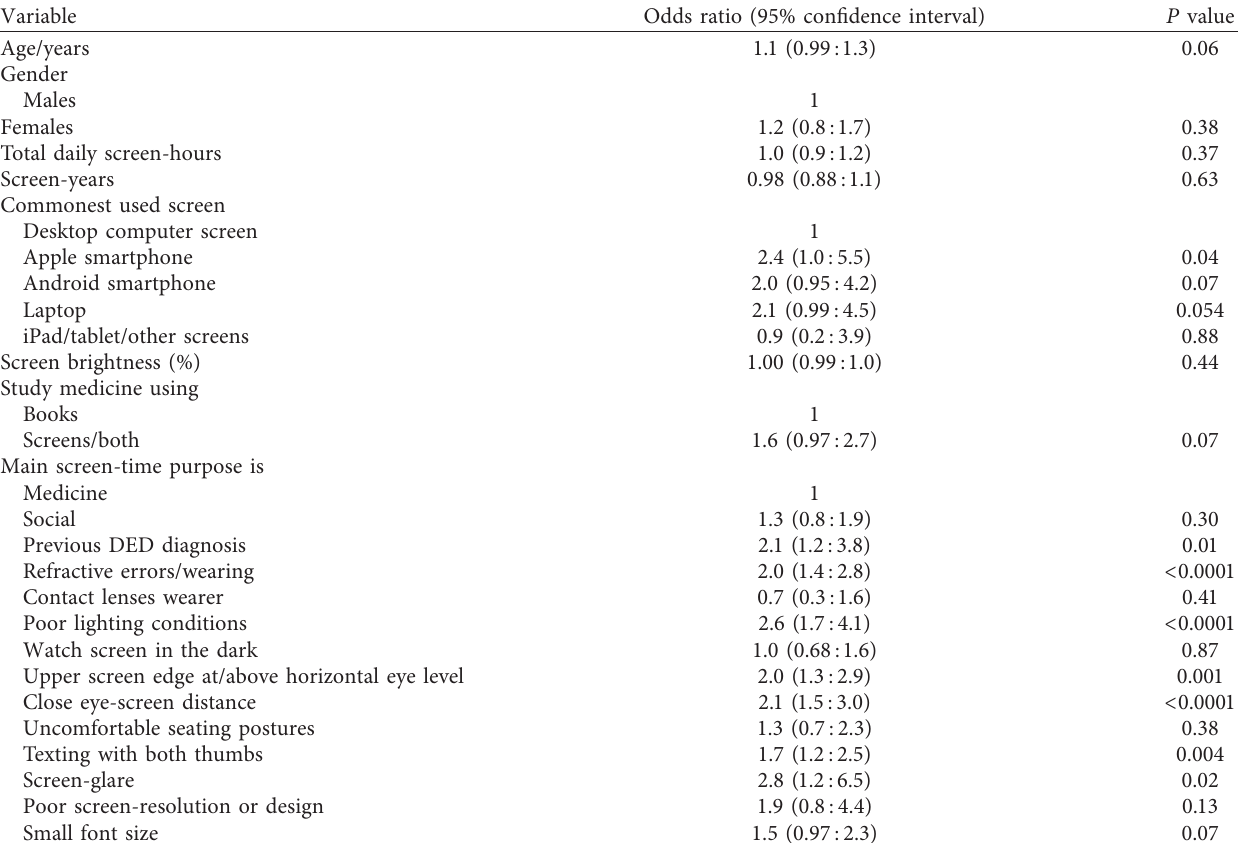
Table 5: Multivariate logistic regression analysis of factors affecting the occurrence of blurred vision.